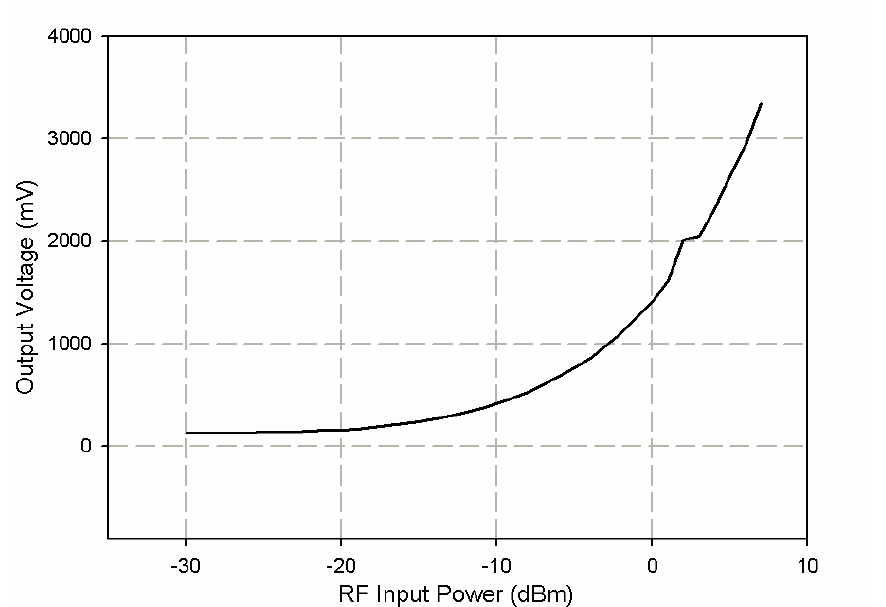
Figure 13. Measured RF power-DC voltage conversion curve at 2.45